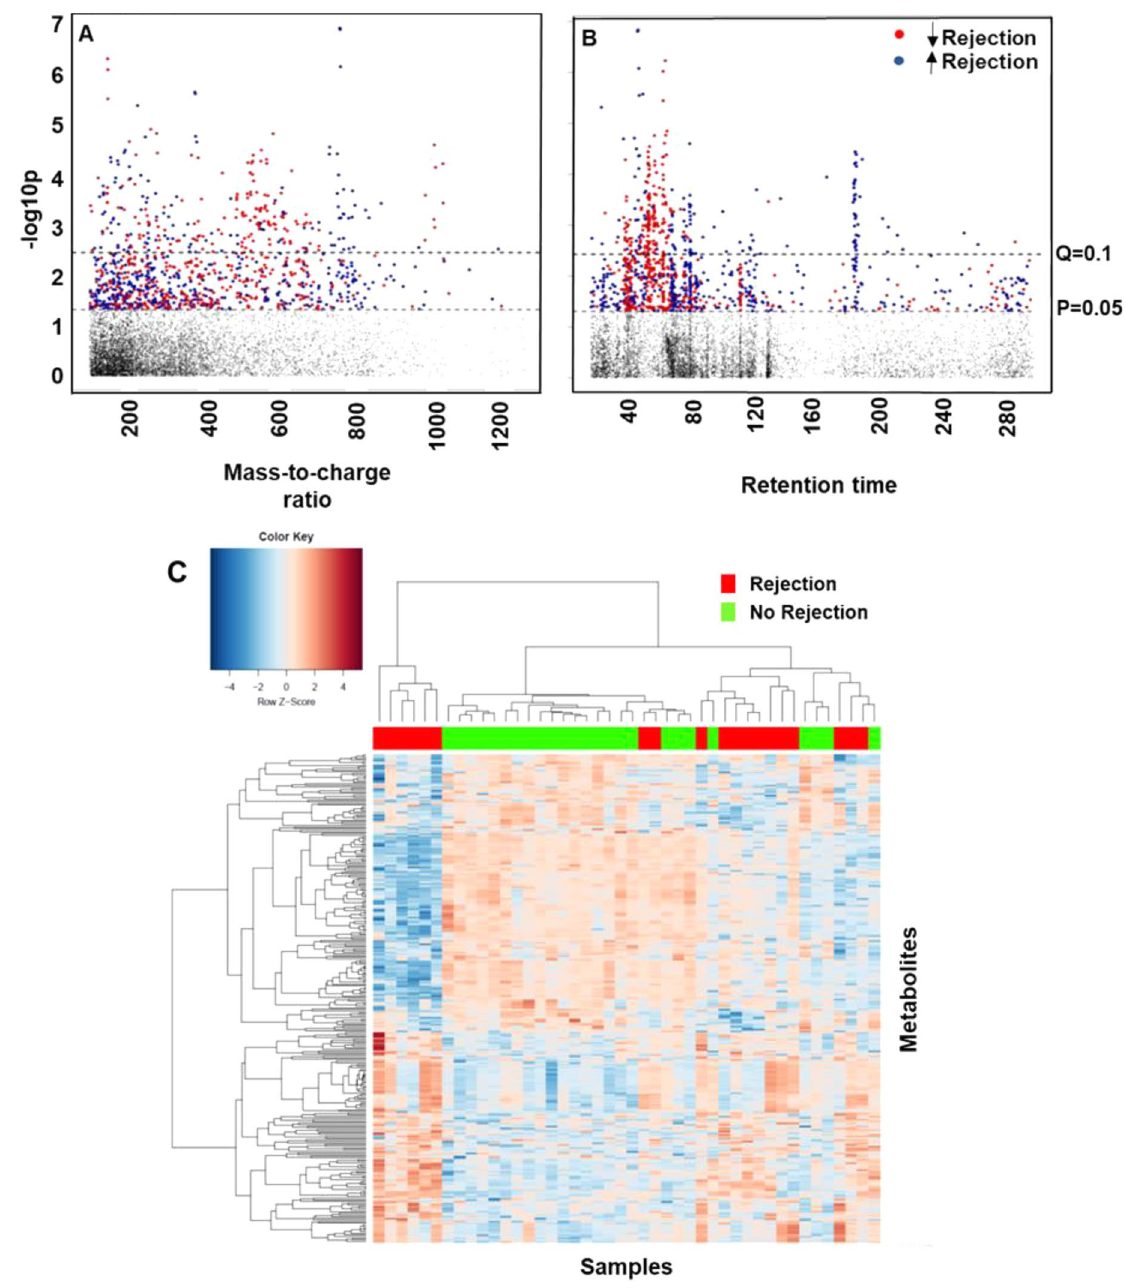
Figure 1. Data visualization: ( A ) and ( B ) are Manhattan Plots derived from the linear regression. The red dots are lower within the rejection group, while the blue dots are higher. On the y-axis –log 10p, ( A ) represents Type I Manhattan plot with x-axis showing the m/z ; whereas ( B ) represents type II Manhattan plot with x-axis showing the retention time (s). A significant m/z was determined for 292 metabolites at q = 0.1. ( C ) is atwo-way Hierarchical Cluster Analysis derived from the linear regression using the m/z of all the significant features. Red = Rejection, Green = No rejection. The y-axis represents the m/z , while the x-axis represents the